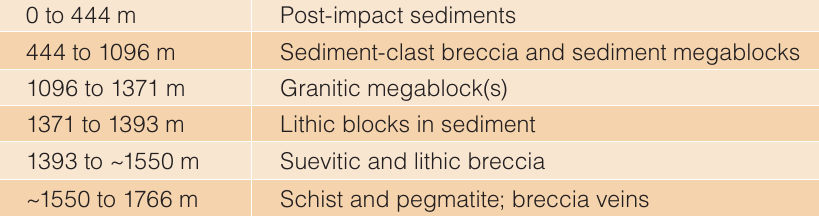
Table 2: Preliminary composite geologic section for Eyreville boreholes (Gohn et al., 2006; Reimold et al., 2006)